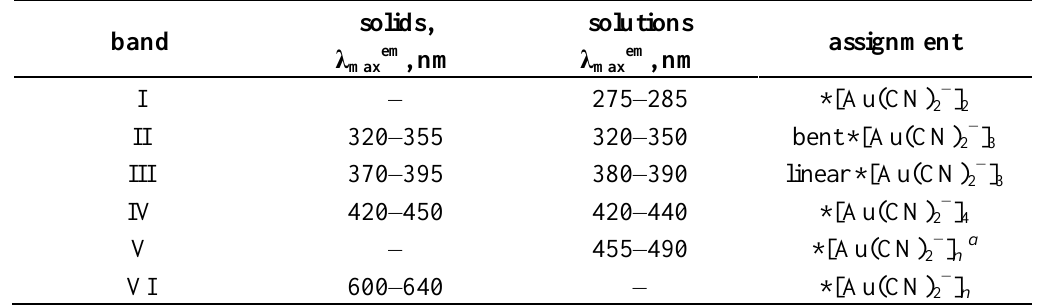
Table 2. General Qualitative Assignment of the Emission Bands Observed in Solids and Solutions of Au(CN) -Species. (Adapted with permission from [38]. Copyright 2002 2 American Chemical